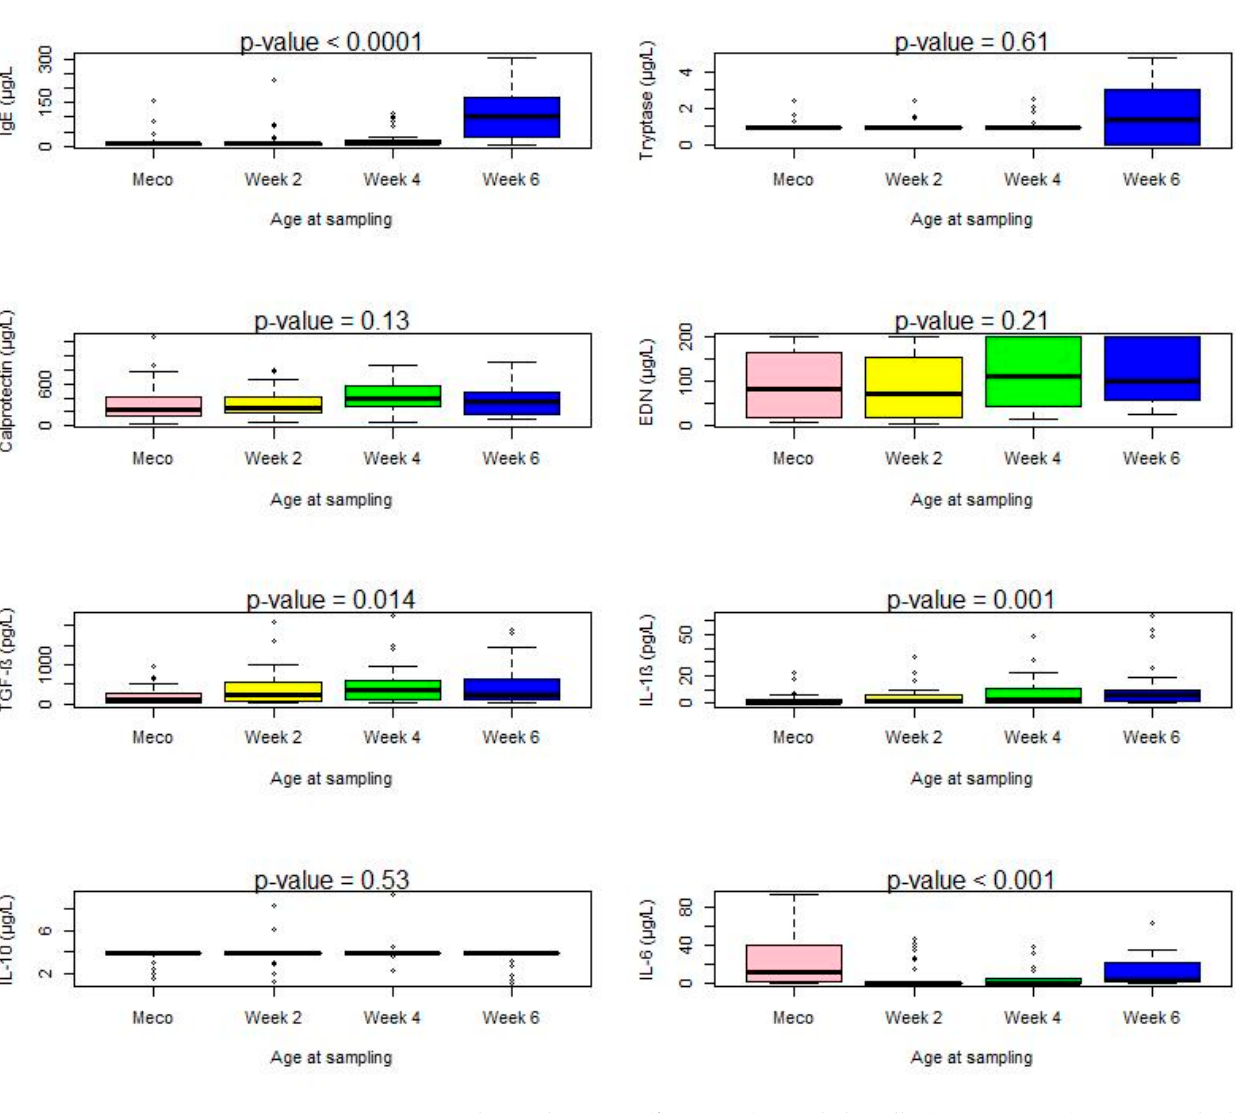
Figure 2. Statistical test: chi-square (frequency), Kruskal–Wallis (concentration). NC, not calculable (calprotectin and EDN were detectable in all samples and at all sampling times).